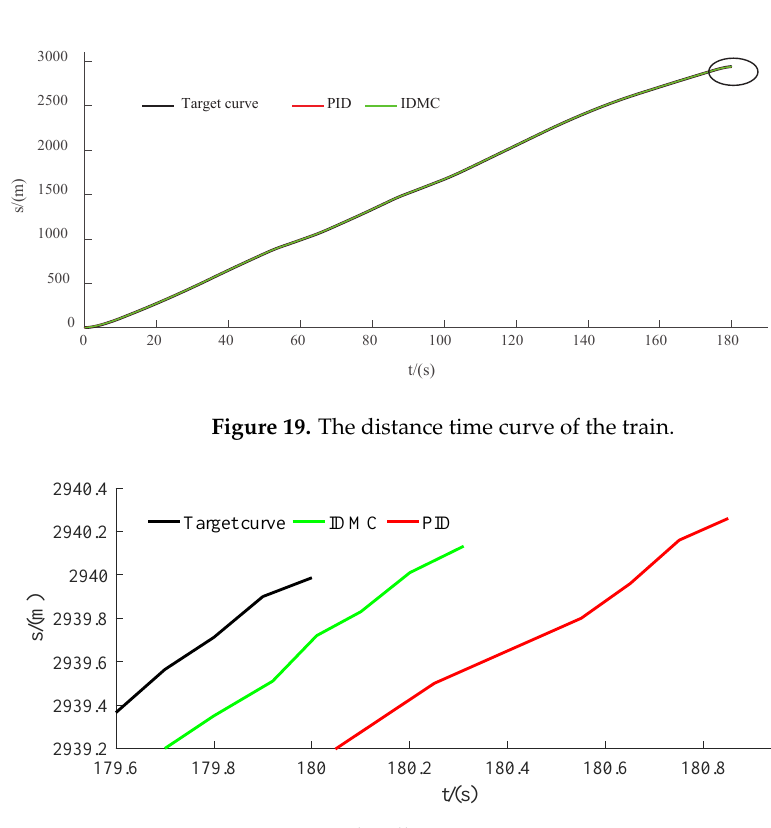
Figure 20. The elliptic region in Figure